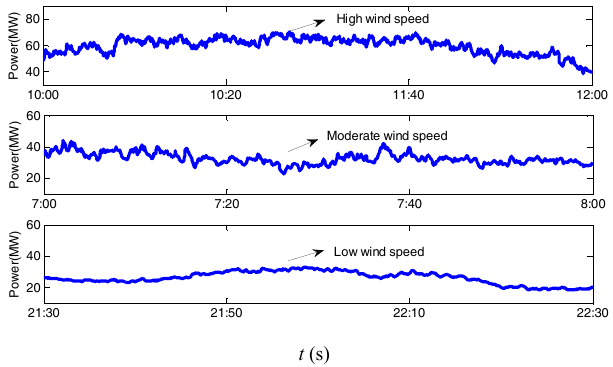
Figure 10. Comparison of wind power at different wind speeds.